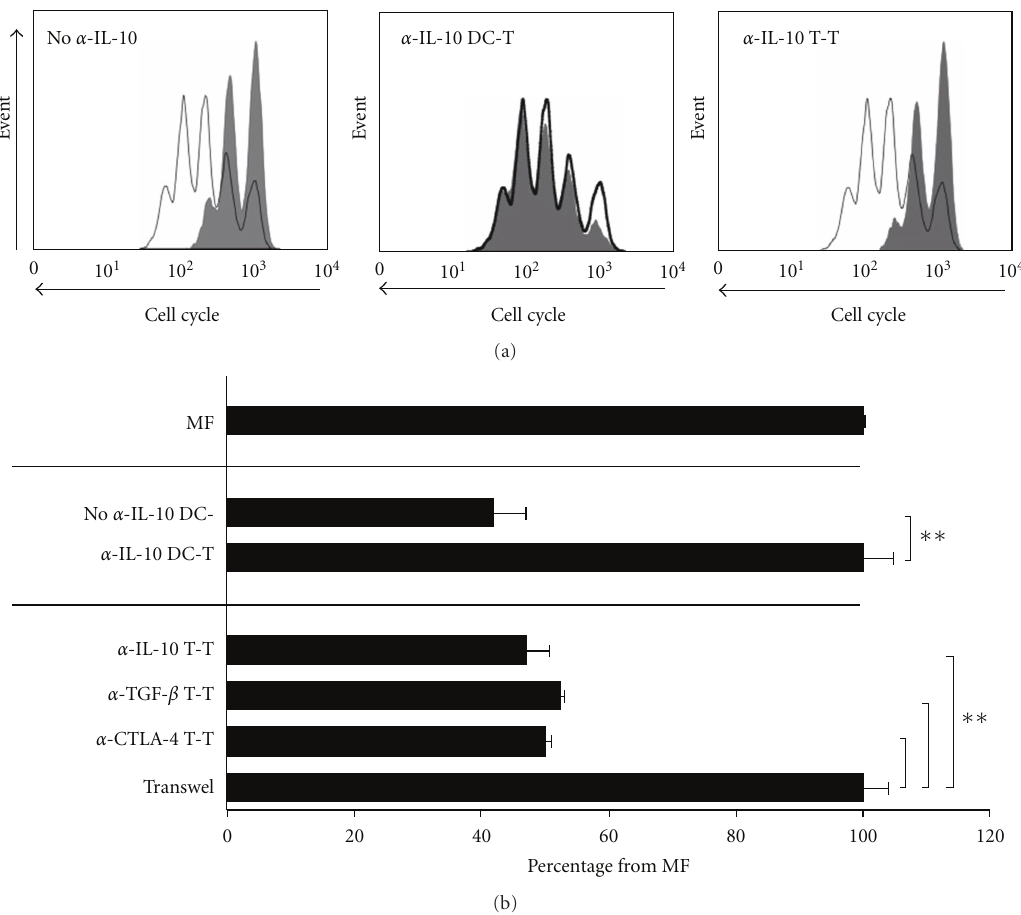
Figure 3: (a) Immature DCs were not matured, matured with MF or with 1 × 10 5 cfu of viable L. lactis , L. lactis IL - 10 , L. lactis IL - 10 / α -IL-10, or L. lactis IL - 10 /rat IgG 1 in the presence of MF. Mature DCs were harvested after 48 hours, washed, and restimulated (2 × 10 4 cells in 200 μ L) for 48 hours with CD40L transfected irradiated hybridoma cells to assess IL-10 production or in combination with IFN- γ to asses IL-12p70 production. Mean values with standard error of mean are given; ∗ indicates P < 0 . 05 and ∗∗ indicates P < 0 . 01 using heteroscedastic Student t -test. (b) Immature DCs were not matured, matured with MF or with 1 × 10 5 CFU of viable L. lactis , L. lactis IL - 10 , L. lactis IL - 10 / α -IL-10 or L. lactis IL - 10 /rat IgG 1 in the presence of MF. Mature DCs were subsequently cultured with na¨ıve Th-cells for 5 days, these DC derived Th-cells were washed and restimulated with CD3/CD28 (100.000 cell/200 μ L, final concentration 1:1000) to assess IL-10 and IFN- γ production. Mean values with standard error of mean are given; ∗∗ indicates P < 0 . 01 using heteroscedastic Student t